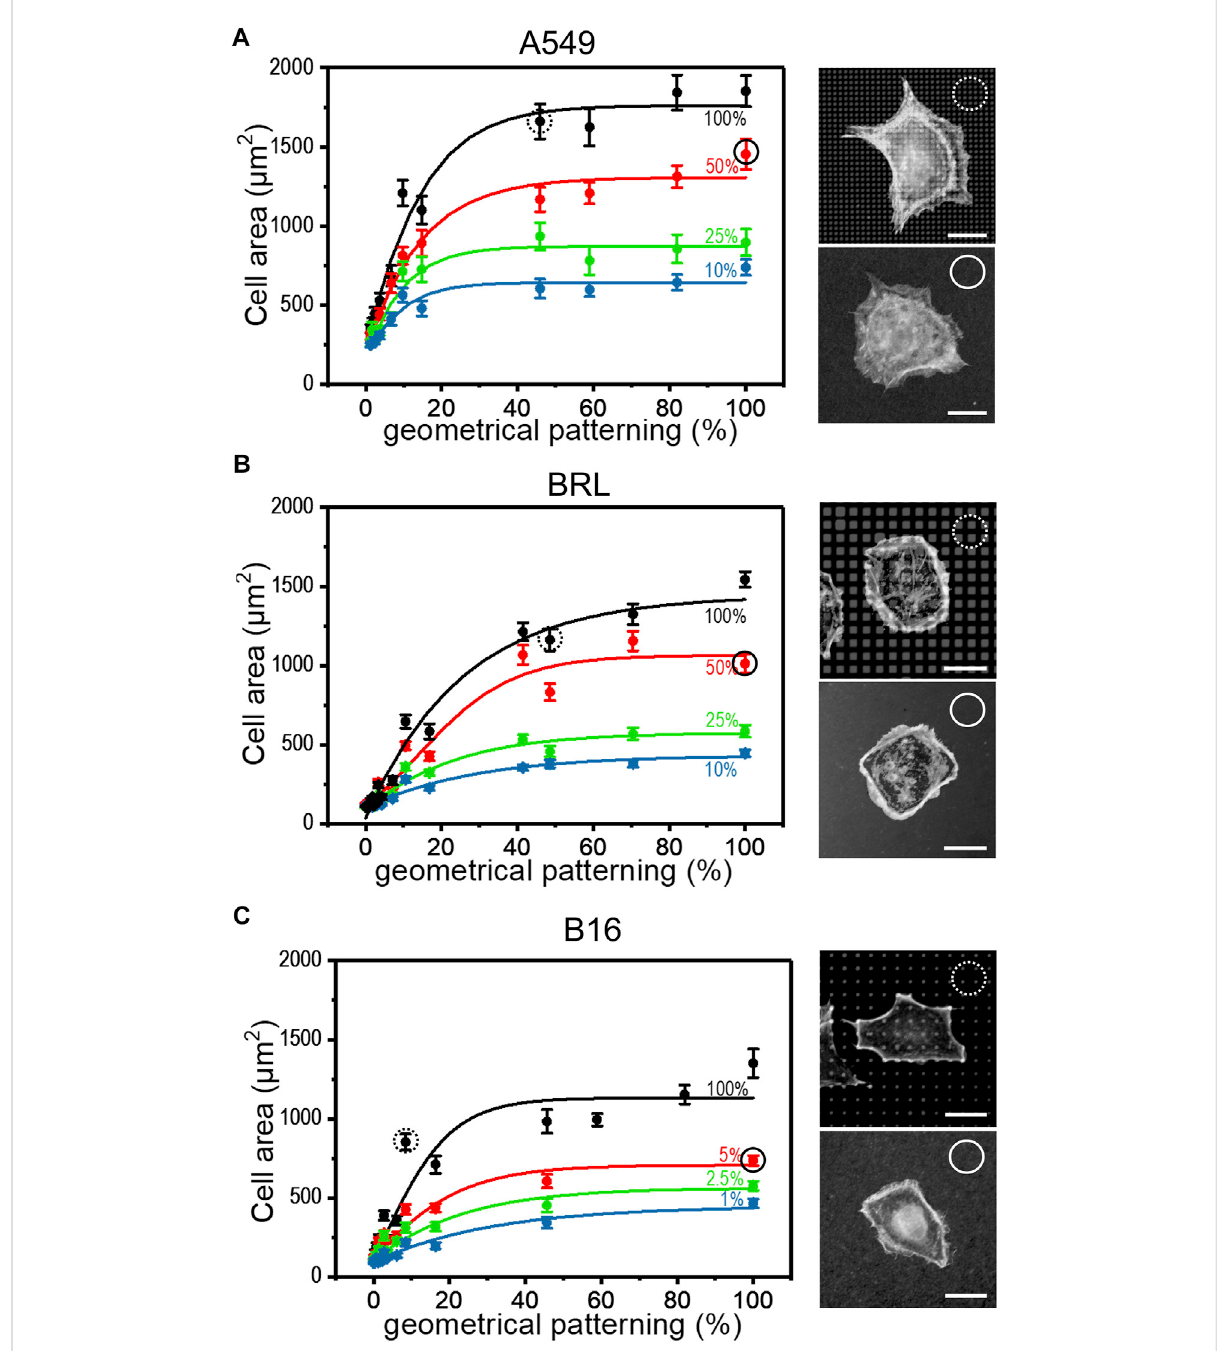
FIGURE 2 Cell spreading depends on FN availability. The aFN dilution and the geometrical pattern approaches were merged to show that the cell spreading areas have the same trend independently in both cases. Representative cells for 50% aFN dilution on fl at surfaces (continuous circle) and undiluted aFN on 50% patterns (dotted circles) are shown on the right of each cell area graph. Average cell spreading area values indicated in dotted and continuous circles are statistically non-signi fi cant. (A) : A549 cells. (B) : BRL cells. (C) : B16